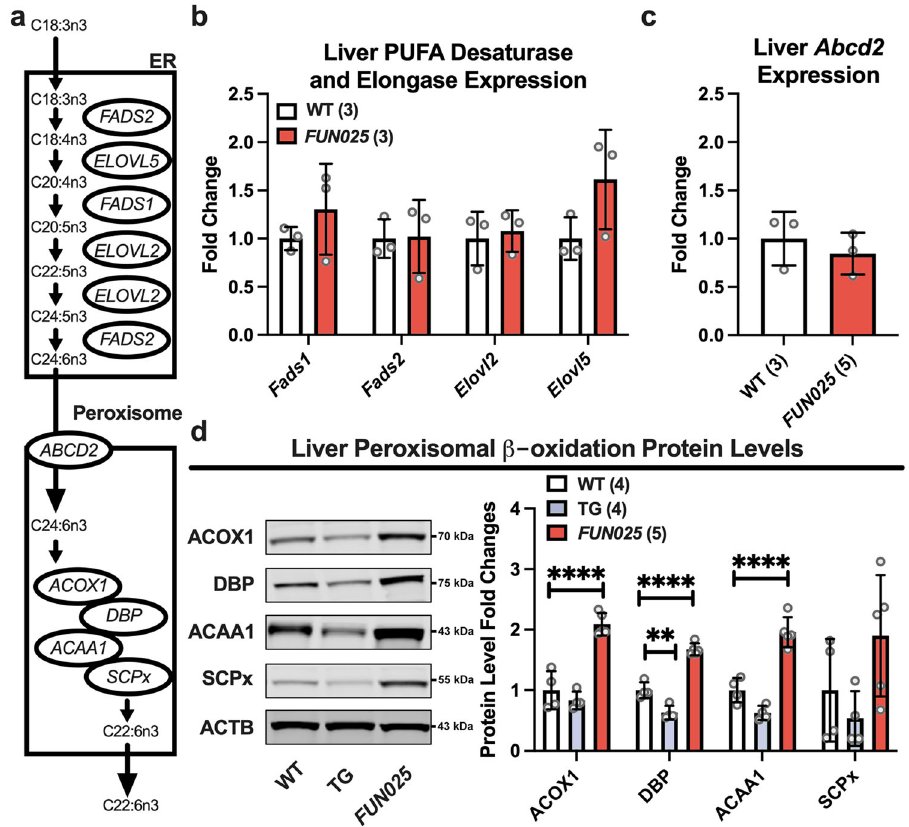
Fig. 3 Peroxisomal beta-oxidation enzymes are increased in Tmem135 mutant livers. a Schematic of the Sprecher pathway of docosahexaenoic acid (C22:6n3) synthesis from alpha-linolenic acid (C18:3n3) through a series of elongation and desaturation steps in the endoplasmic reticulum (ER) that is fi nished within peroxisomes via their beta-oxidation machinery. b Gene expression analysis of the ER-localized Fatty acid desaturase 1 ( Fads1 ) and 2 ( Fads2 ) and Elongation of very-long-chain fatty acids-like 2 ( Elovl2 ) and 5 ( Elovl5 ) involved in the Sprecher pathway in the livers of three 2.5-month-old female WT and Tmem135 FUN025/FUN025 ( FUN025 ) mice. c Gene expression analysis of ATP binding cassette subfamily D member 2 ( Abcd2 ) in the livers of three 2.5- month-old female WT and Tmem135 FUN025/FUN025 mice. Ribosomal protein lateral stalk subunit P0 ( Rlplp0 ) served as the housekeeping gene in these studies. d Western blot analysis of peroxisomal beta-oxidation enzymes including acyl-CoA oxidase 1 (ACOX1), D-bifunctional protein (DBP), acetyl-Coenzyme A acyltransferase 1 (ACAA1), and sterol carrier protein x (SCPx) using liver lysates from 2.5-month-old WT, Tmem135 TG (TG), and Tmem135 FUN025/FUN025 mice. ACTB served as the loading control for these experiments. 4 WT (2 males/2 females), 4 Tmem135 TG (2 males/2 females), and 5 Tmem135 FUN025/ FUN025 (3 males/2 females) were used in these experiments. Asterisks (** and ****) indicates post hoc Tukey test for a P < 0.01 and P < 0.0001 signi fi cance following a signi fi cant difference detected by one-way ANOVA. Dots represent individual data points. The number in parentheses represents the N of independent mouse samples per genotype used in the experiment. The protein size next to the immunoblot images denotes the size of the immunoband measured for this analysis. These experiments were repeated twice to ensure reproducibility. Data are presented as mean ±